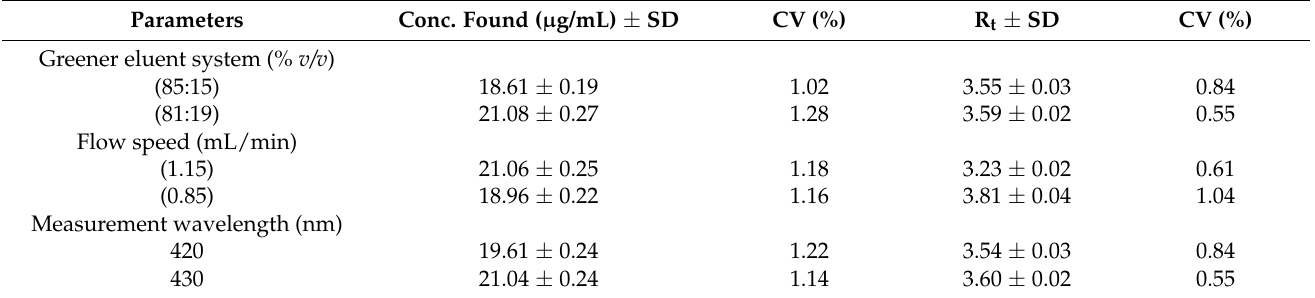
Table 6. Robustness data of CCM at MQC (20 µ g/mL) for the greener HPLC methodology (mean ± SD; n = 3).